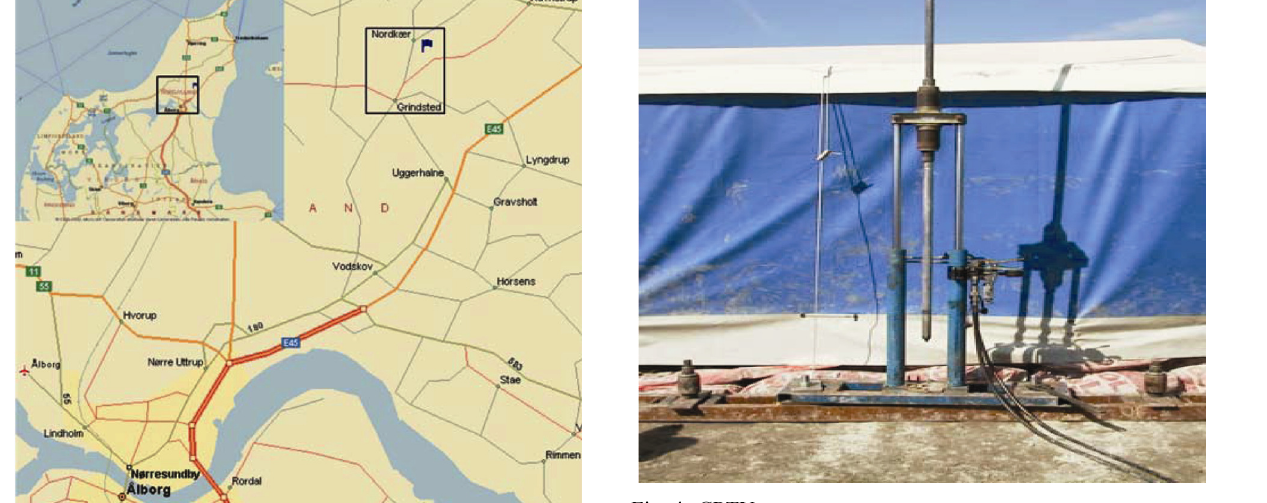
Fig. 4. CPTU test apparatus Table 1. Experimental u c values (Ibsen, Barari 2011)